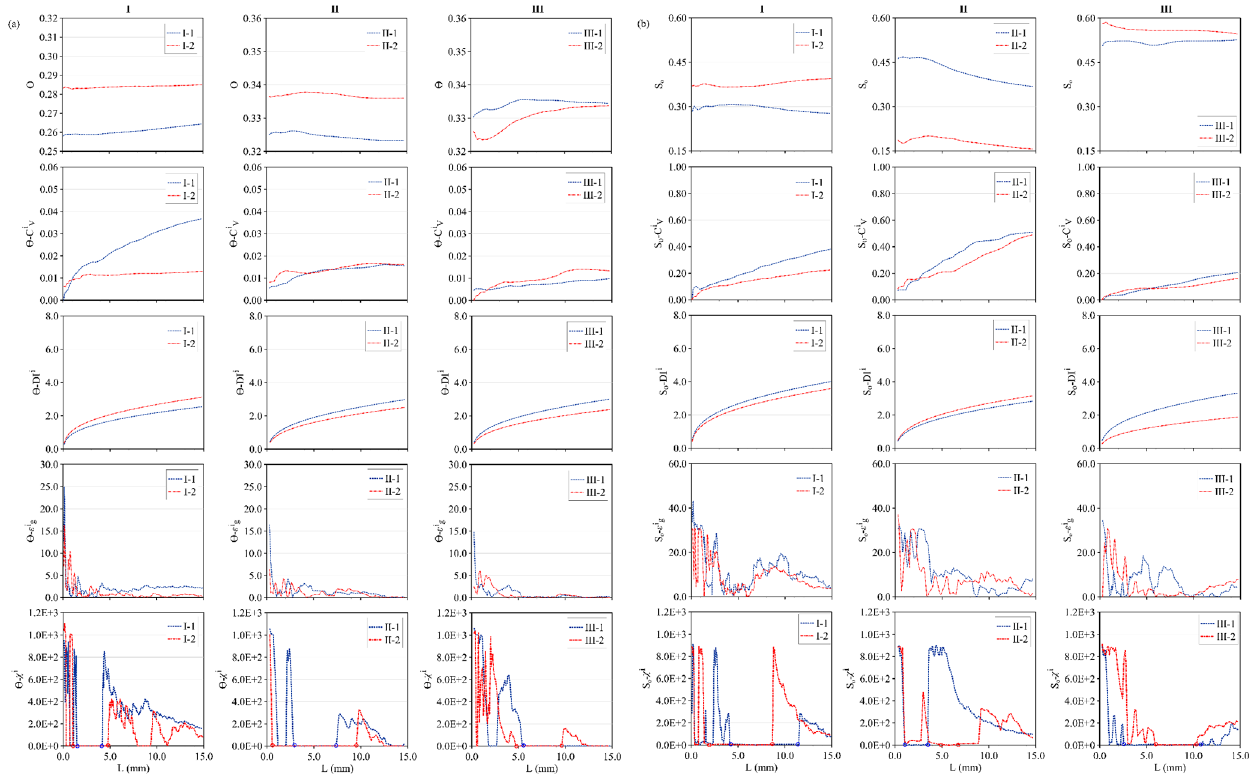
Figure 4. (a) The change in porosity ( θ ), associated coefficient of variation ( C i new criterion- χ i for observation cells as the cuboid window scale ( L ) increases; (b) the change in PCE saturation ( S o ), associated C i ε i g , and χ i for observation cells as the cuboid window scale ( L )